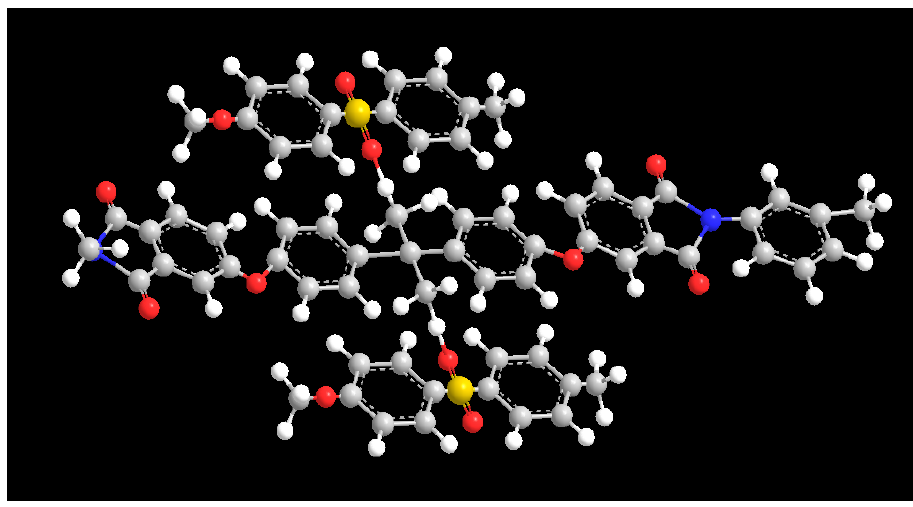
Figure 5. π–π stacking and hydrogen bonding model between PES and PEI. Figure 5. π – π stacking and hydrogen bonding model between PES and